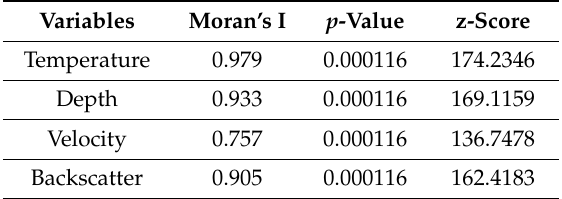
Figure 5. Moran scatter plots to identify the spatial autocorrelation for various ADCP-based observations: ( a ) temperature, ( b ) bathymetry, ( c ) velocity, and ( d ) backscatter. Table 1. Global Moran’s I and its statistics applied for each parametric map produced from the ADCP